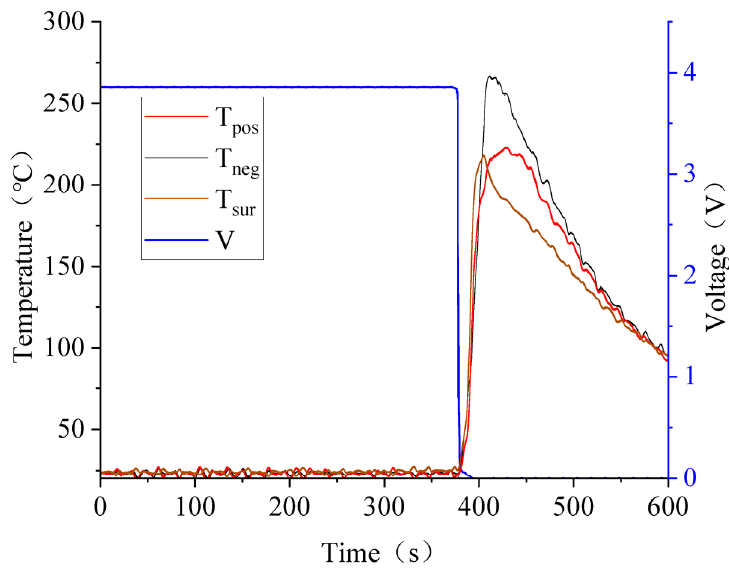
Figure 13. 60% SOC state battery curve.